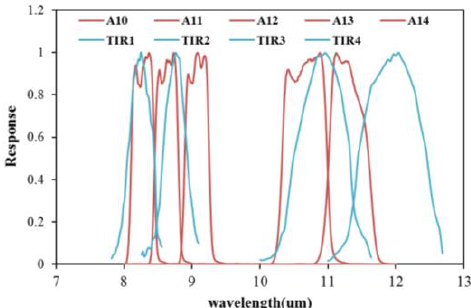
Figure 1. Spectral response functions of GF-5 TIR (TIR1-4) and ASTER TIR (A10-14)